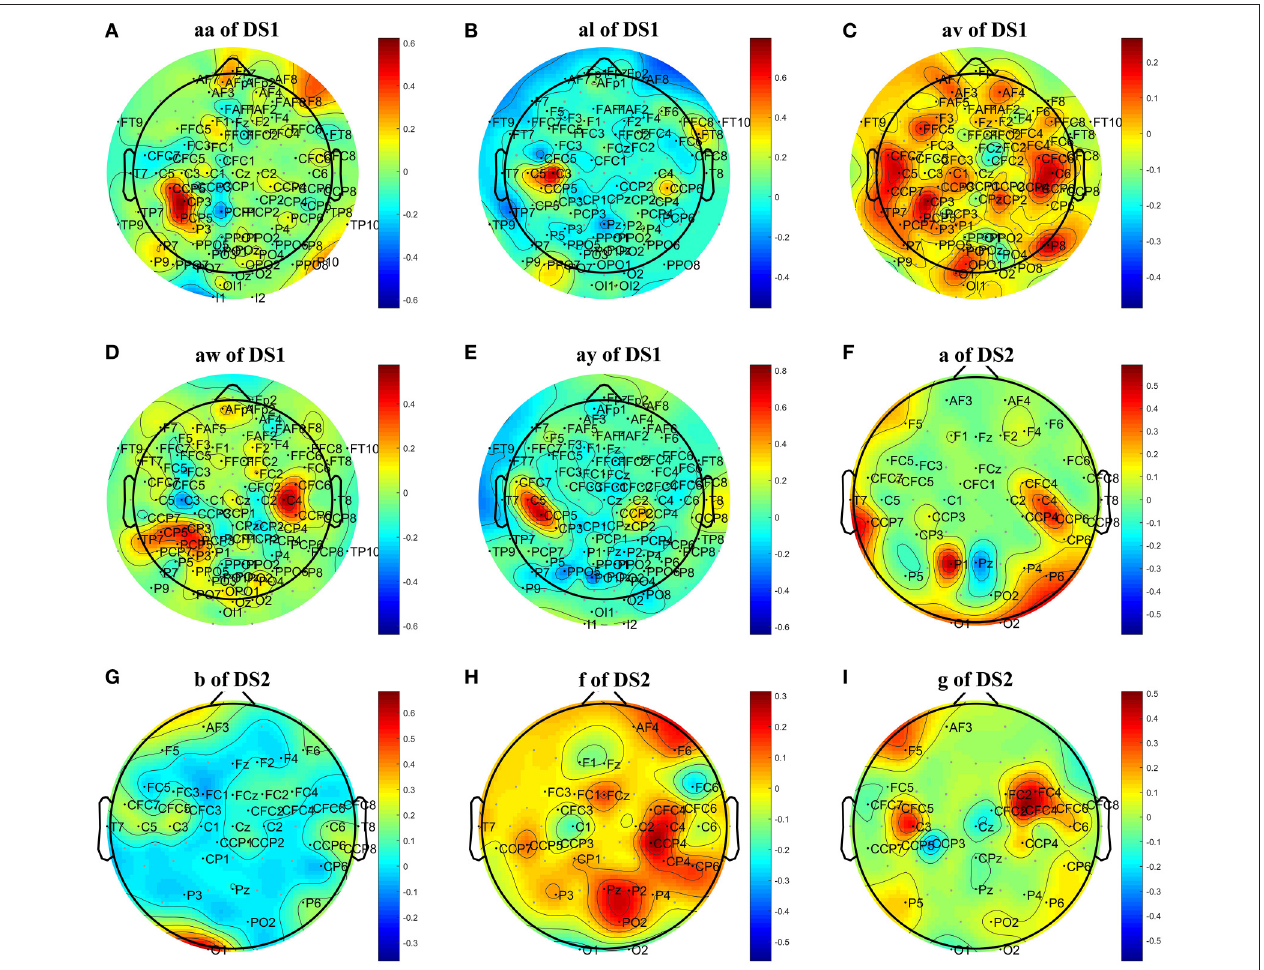
FIGURE 4 | Topographical map of optimal channels and weights with L2 norm regularization term on subjects: (A) aw of DS1, (B) av of DS1, (C) al of DS1, (D) aa of DS1, (E) ay of DS1, (F) a of DS2, (G) b of DS2, (H) f of DS2, (I) g of